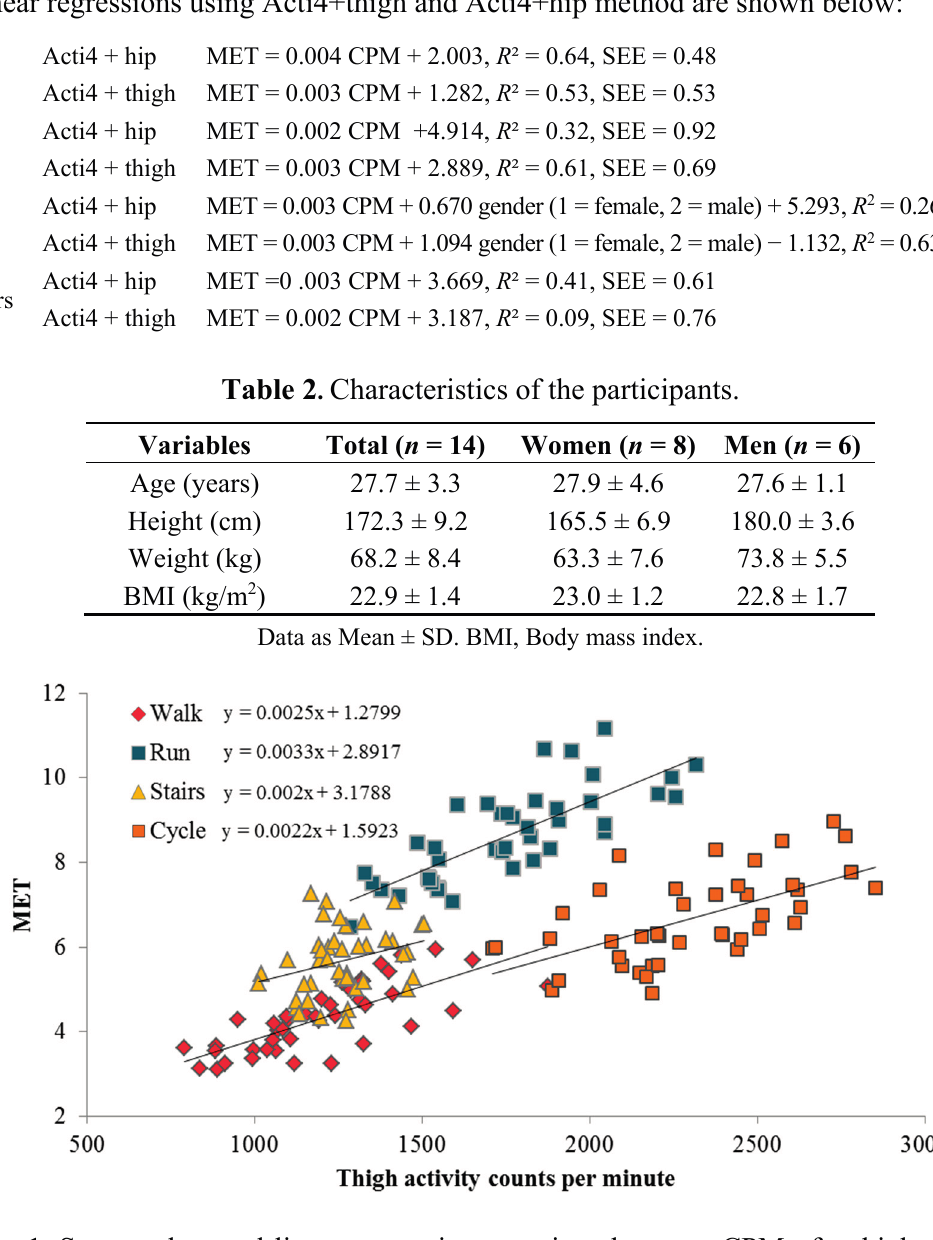
Figure 1. Scatter plots and linear regression equations between CPM of a thigh-mounted ActiGraph GT3X+ accelerometer and EE measured by indirect calorimetry of physical activity